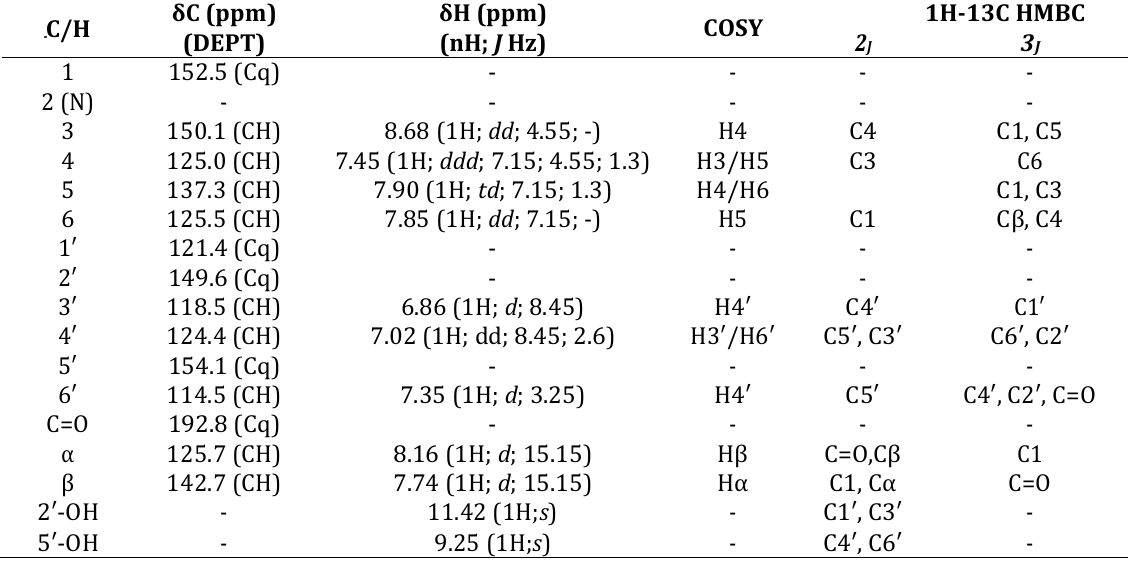
Table II. NMR spectra data 1- (2,5-dihydroxyphenyl) - (3-pyridine-2-il) –propenone